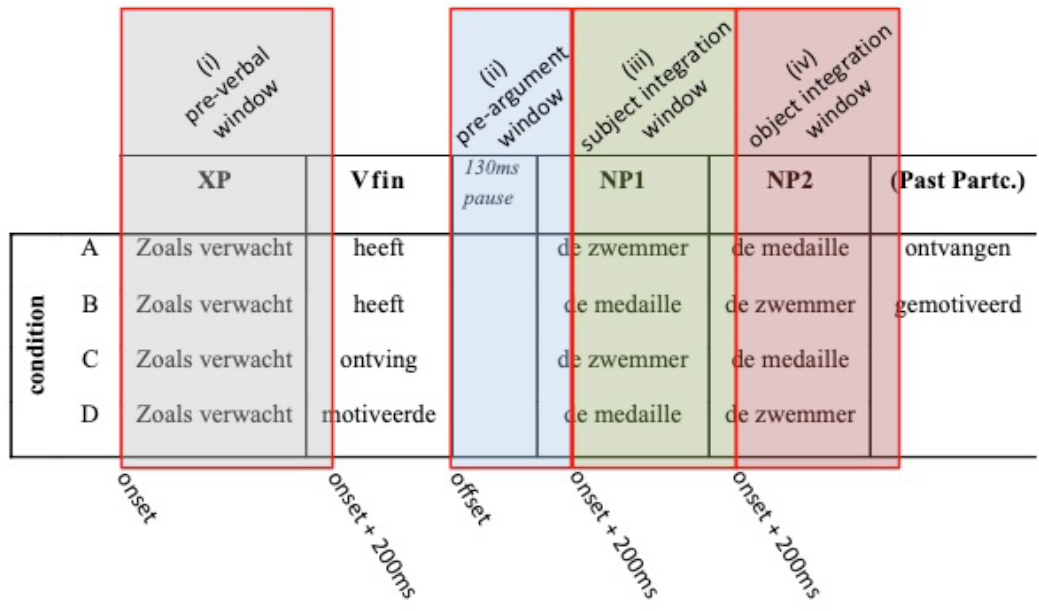
Figure 2: Schematic representation of the windows of analysis with an example sentence per condition: (i) the pre-verbal window (sentence onset – verb onset + 200ms), (ii) the pre-argument window (verb offset – NP1 onset + 200ms), (iii) the subject integration window (NP1 onset + 200ms – NP2 onset + 200ms), and (iv) the object integration window (NP2 onset – duration of